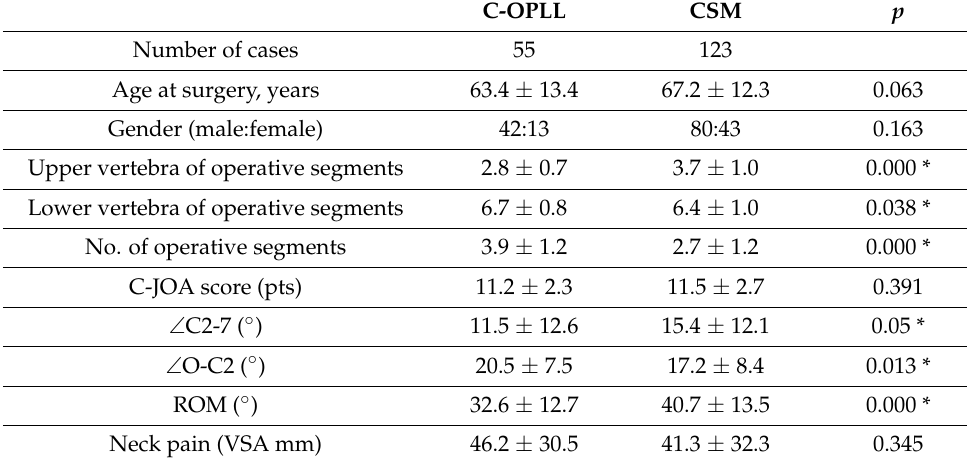
Table 2. Patient demographic data.